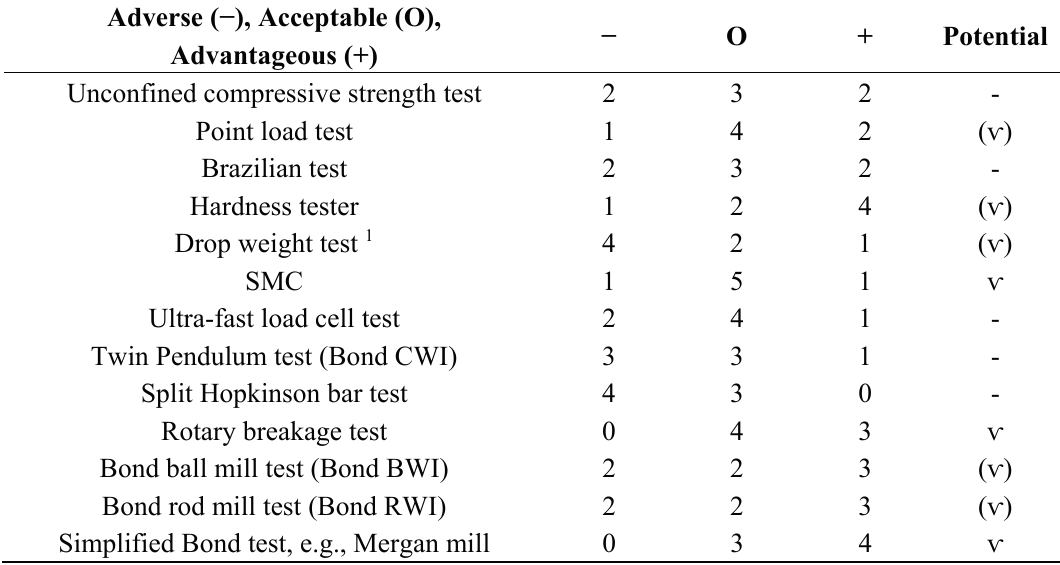
Table 4. Summary table, potential for